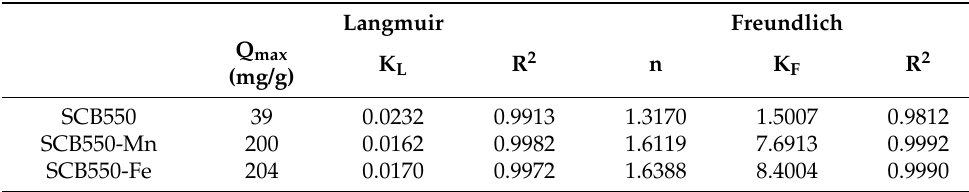
Table 4. Summary of adsorption isotherm modeling